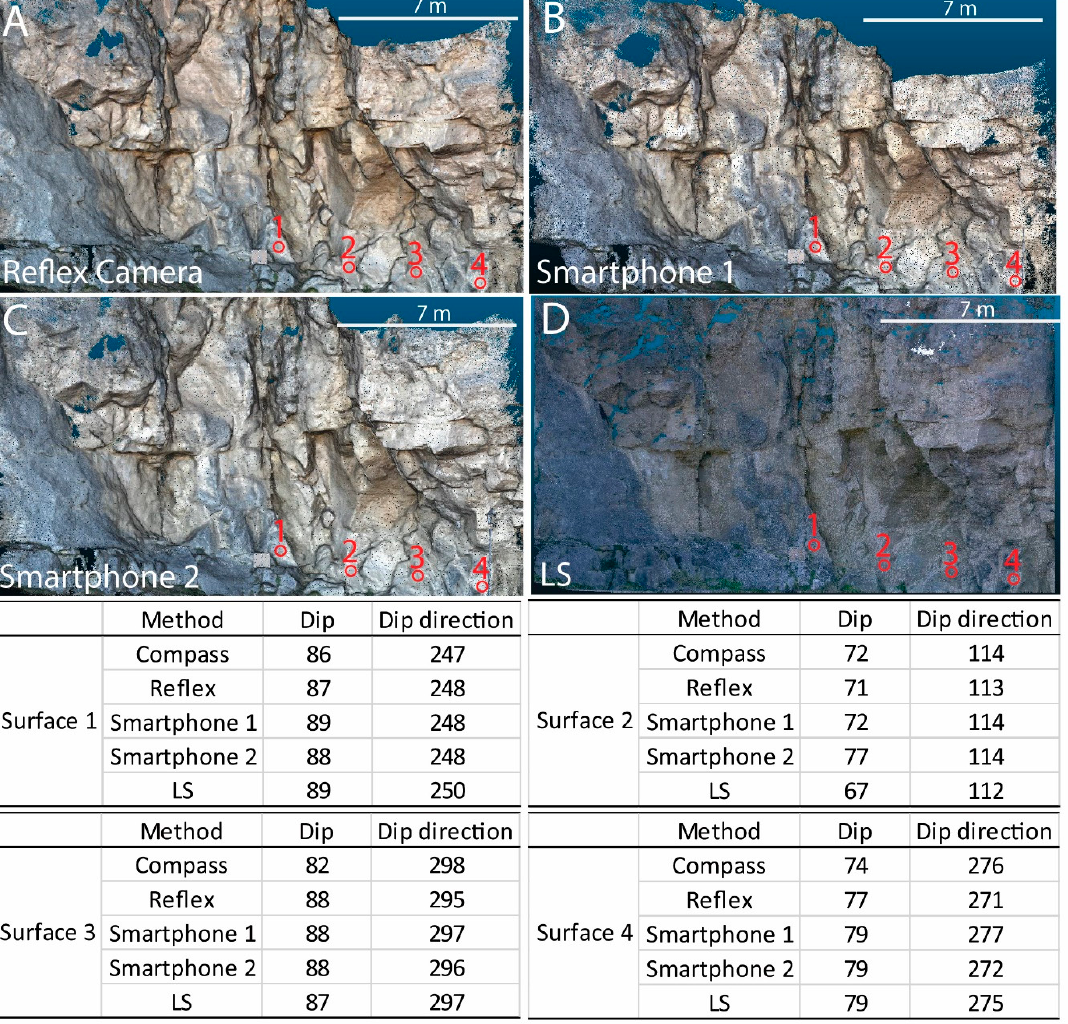
Figure 14. Comparison of dip and dip direction of the discontinuity surfaces measured with a geological compass and from the DP ( A, B and C ) and LS ( D ) models. Calibrated and non-calibrated digital camera models are reported as “reflex” ( A ) since they show similar results.